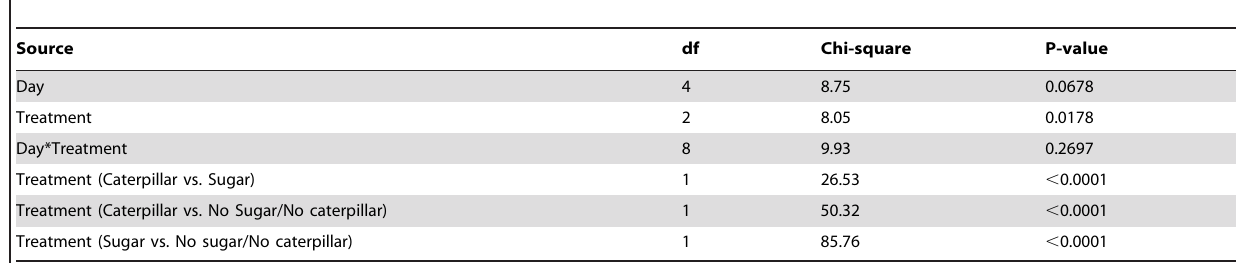
Table 1. Summary of data analysis performed on survival of mosquitoes using different treatments.